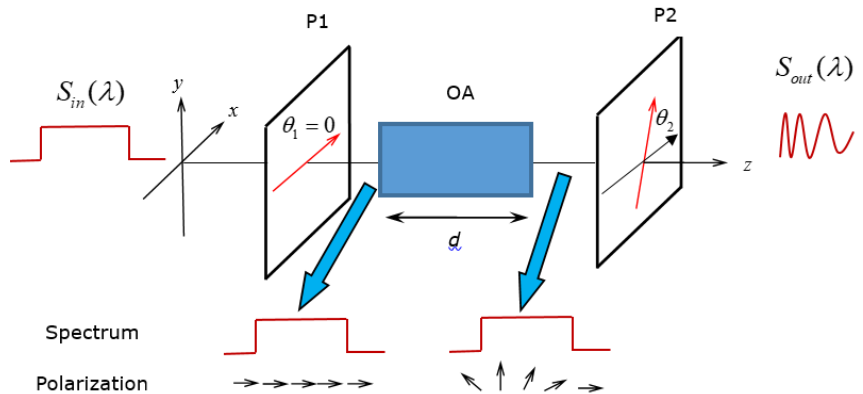
Figure 7. The configuration for illustrating the principle of an optical frequency ruler using optically active material.